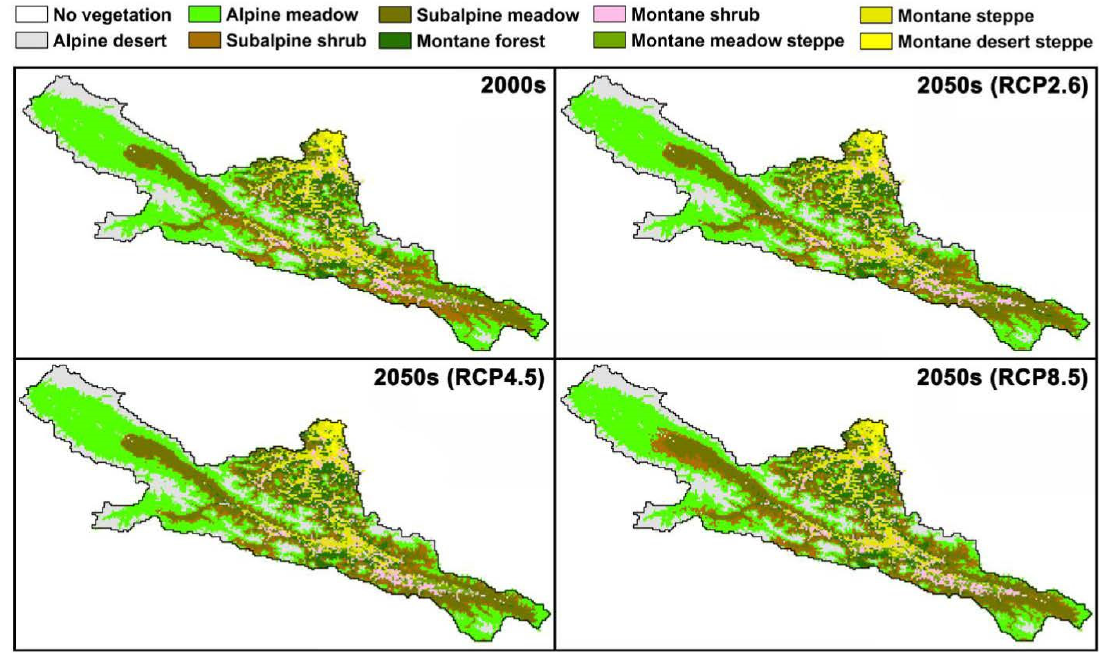
Figure 5. Variation of mean annual precipitation in the 2000s, and precipitation change (difference between precipitation from the 2000s to the 2050s) under the RCP2.6, RCP4.5, and RCP8.5 scenarios, along the elevation gradient for each 1 km × 1 km pixel. Note: the meanings of the gray and blue lines are similar to those in Figure 4.